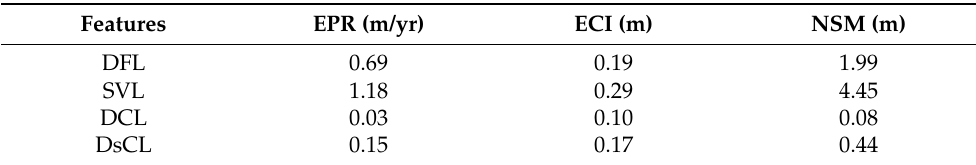
Table 7. DSAS results for each geomorphic line feature. EPR: End Point Rate; ECI: End Point Rate Confidence index; NSM: Net Shoreline